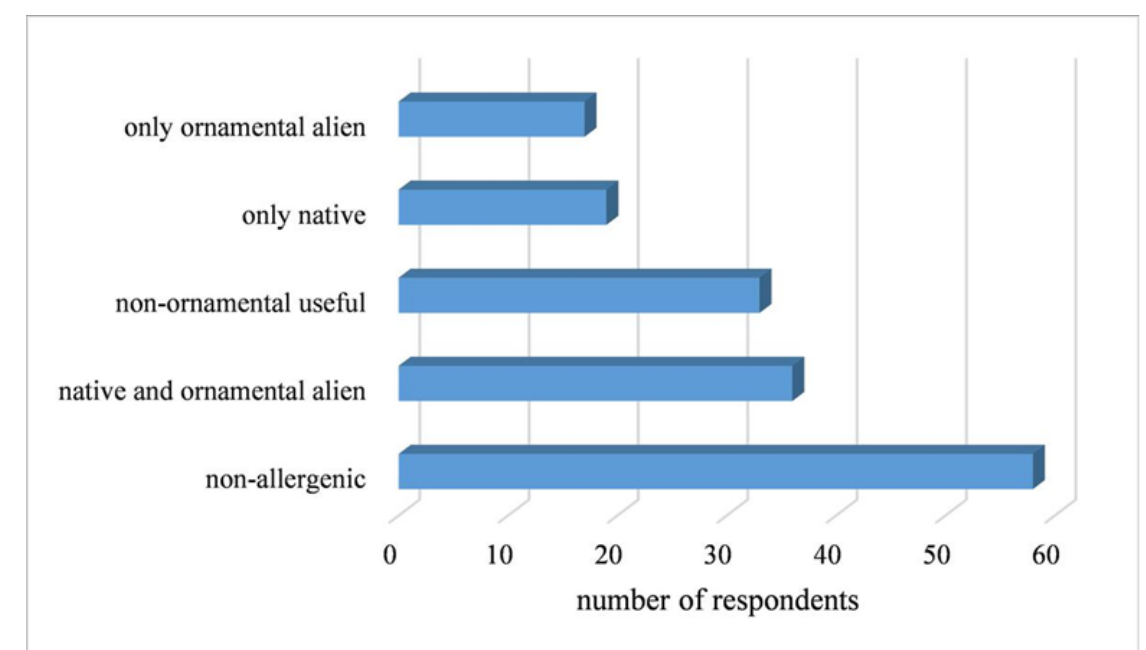
Figure 3. Respondents ’ preferences for plant species creating compositions of greenery.